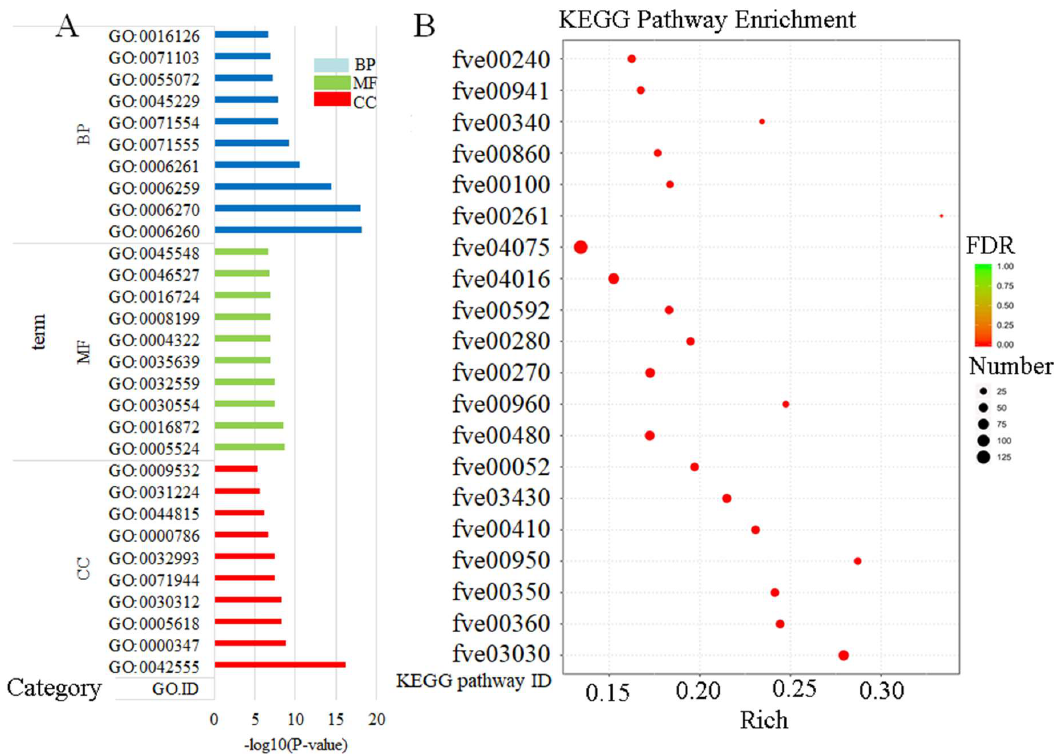
Figure 6. Enrichment analysis of di ff erentially expressed genes. ( A ). The top ten significant enrichment GO term in biological process (BP), molecular function (MF) and cellular component (CC). The abscissa was the logarithm of the significant enrichment P value with the base 10, and the ordinate was the gene ID. ( B ). Top 20 KEGG enrichment pathways by FDR. Rich Factor was the ratio of the di ff erentially expressed number of genes located in the pathway. The higher the Rich Factor, the higher the degree of enrichment. FDR was false discovery rate in the range of 0 to 1, the closer to zero, the more significant the enrichment.